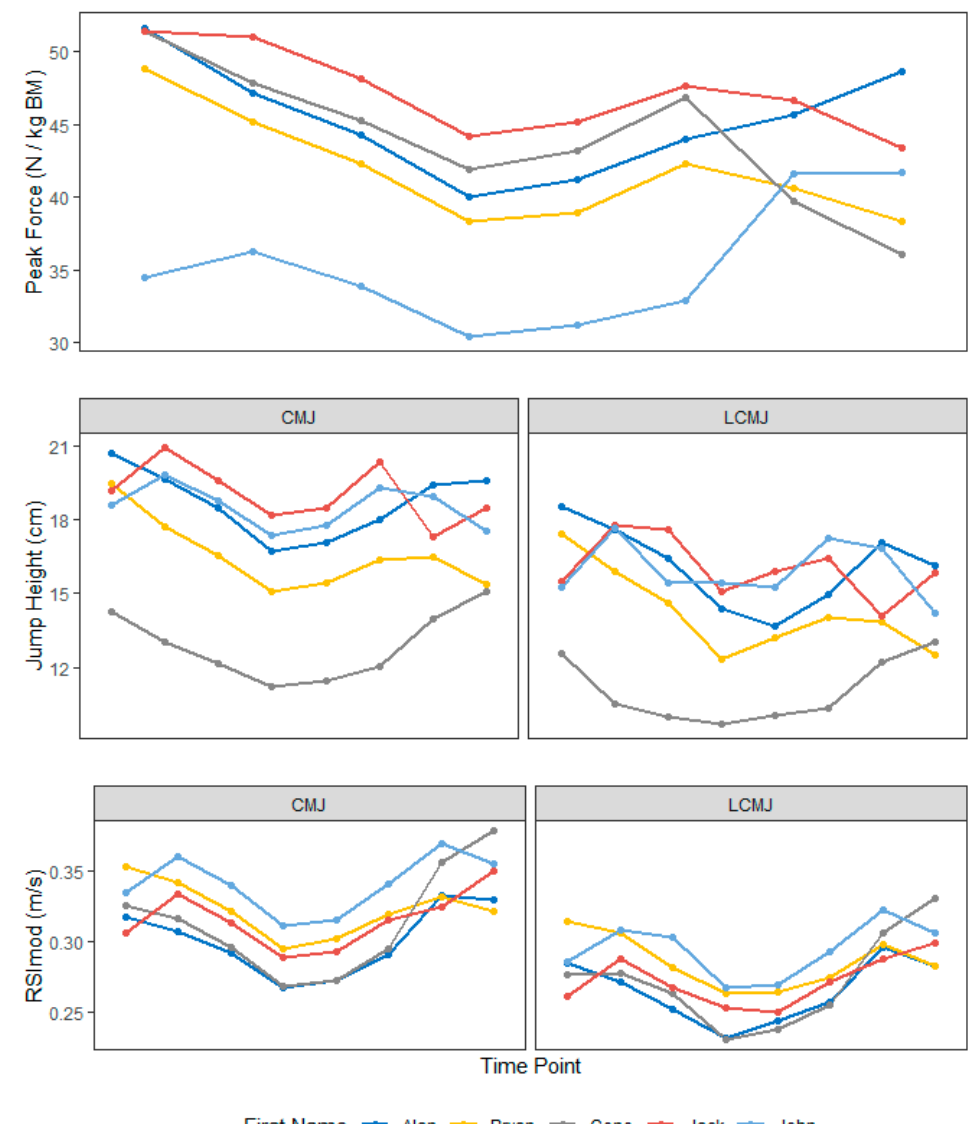
Figure 6. In this example case study, comparisons can be made between individuals and within individuals over time while also noting differences in responses across performance testing and metrics. These synthetic data may show a de- crease for most individuals around the same time of the year, demonstrating examples of intense training bouts or de- training that lead to reductions in performances. Following the bout of training decrements, these individuals demonstrate varying rates of positive performance adaptations. Bryan, John, and Jack had decreased jumping, but John’s strength re- mained stable, while Gene noted consistent improvement in jumping abilities but a decline in isometric strength. Thus, demonstrating the variability in responses to training programs, which may be useful for properly informing training